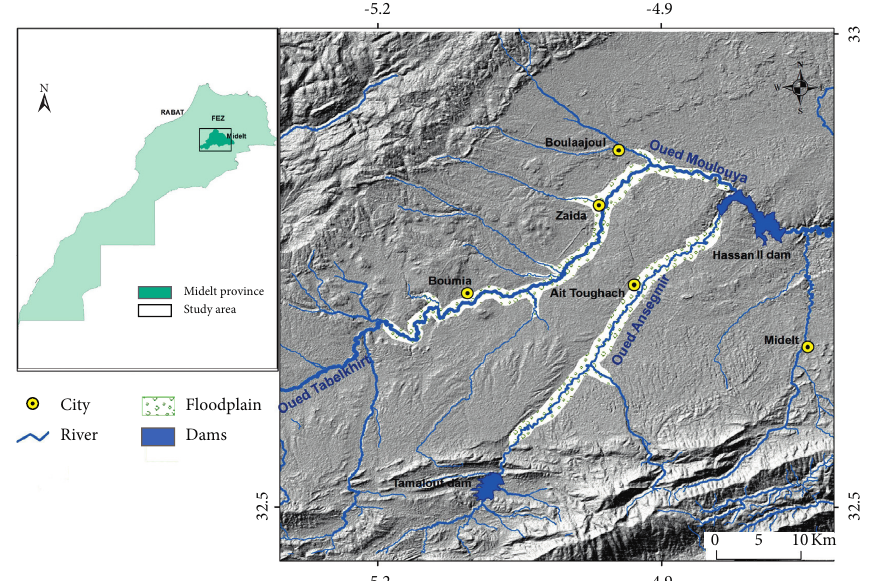
Figure 1: Study rivers of Ansegmir, Moulouya, and Tablkhirt in Moulouya watershed at Midelt Province, Table 1: Abundance of principal vegetation genus identified in the studied rivers at Midelt, Morocco. Type Plants genius Ansegmir Eastern Tablkhirt Western Tablkhirt Poplar sp. +++++ +++++ +++ Salix sp. +++++ Phragmites sp. Wild riparian genus Rubus sp. +++